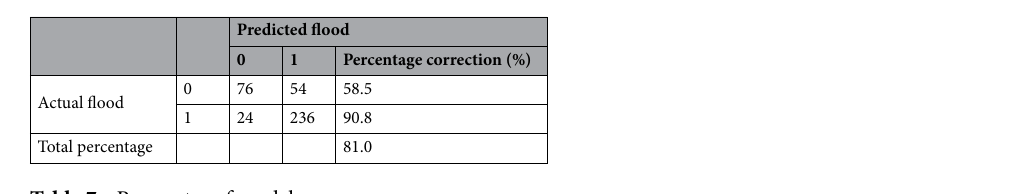
Table 7. Parameter of model.